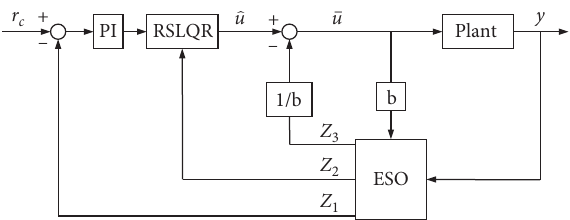
Figure 8: Structure of the RSLQR control based on Table 3: The control gains of the four channels.